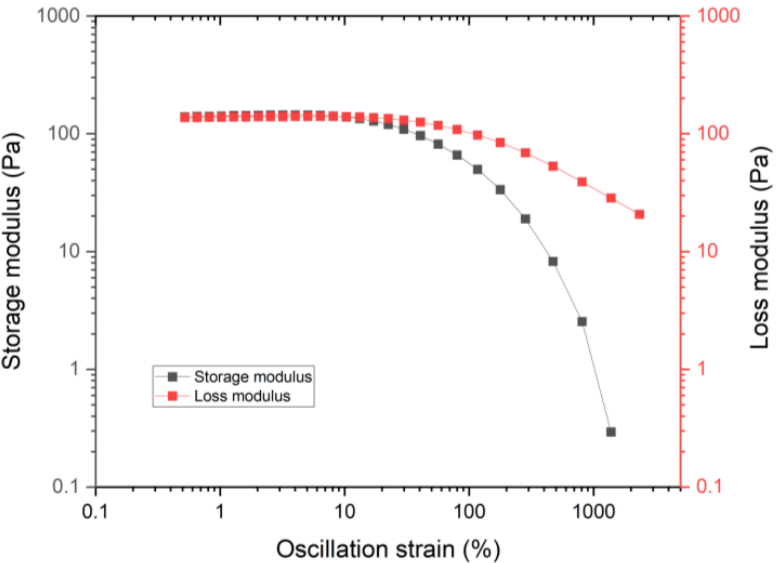
Figure 3. Yield stress analysis of modified Nafion inks by dynamic strain sweep. Black dotted line: storage modulus; red dotted line: loss modulus.